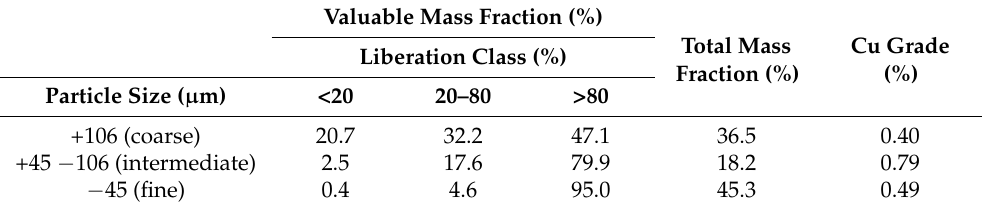
Table 1. Feed characteristics of BVC cell used to carry out the scenario